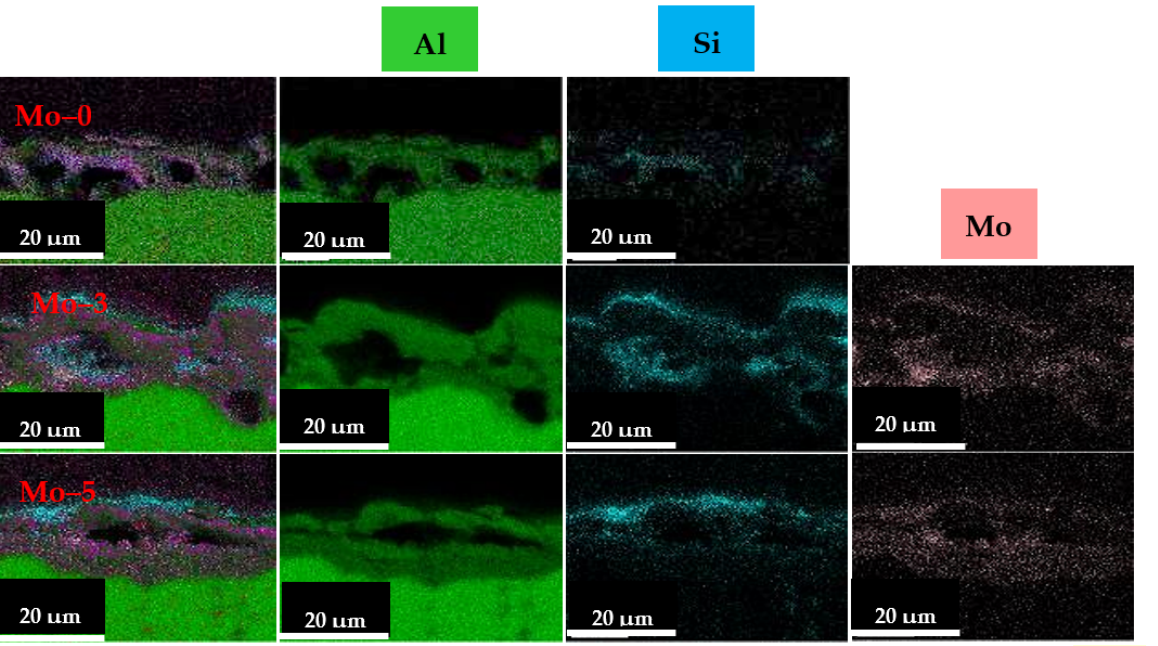
Figure 4. The elemental maps on the cross ‐ section of the PEO specimens prepared in the silicate ‐ based solution with and without additive at various Na 2 MoO 4 concentrations that consist of Al, Si, and Mo elements marked by green, blue, and pink colors, respectively.